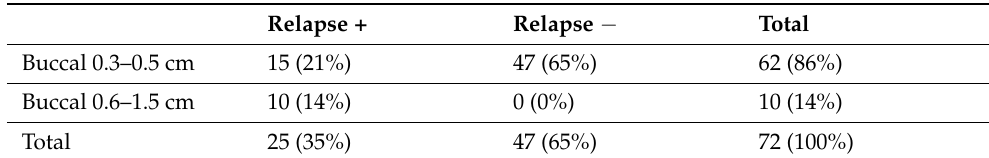
Table 4. Crosstabulation for use of buccal advancement flap in case of defects ranged between 0.3 cm and 0.5 cm and in case of defects ranged between 0.6 cm and 1.5 cm.